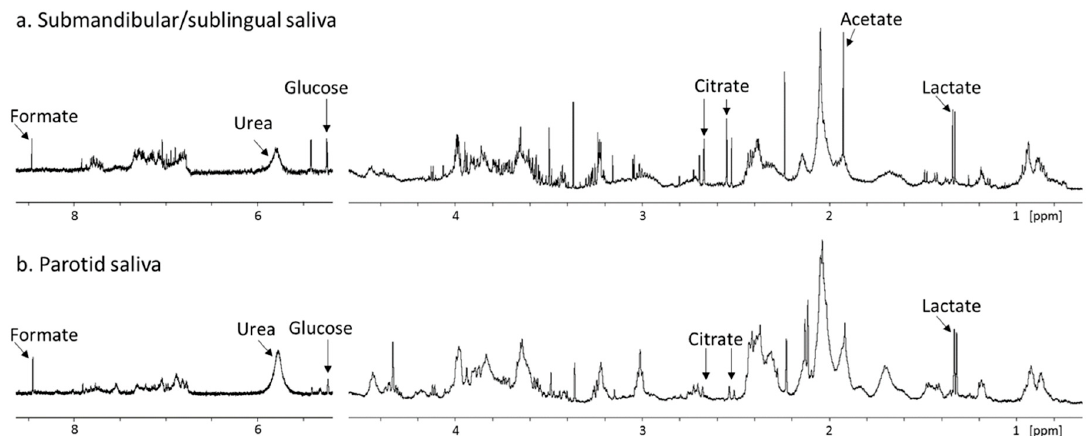
Figure 4. Partial 600 MHz 1D 1 H-NMR spectra ( δ 0.7 to 8.5 ppm, excluding δ 4.5 to 5.5 ppm), comparing a . submandibular/sublingual saliva and b . parotid saliva from the same donor. Prominent peaks are